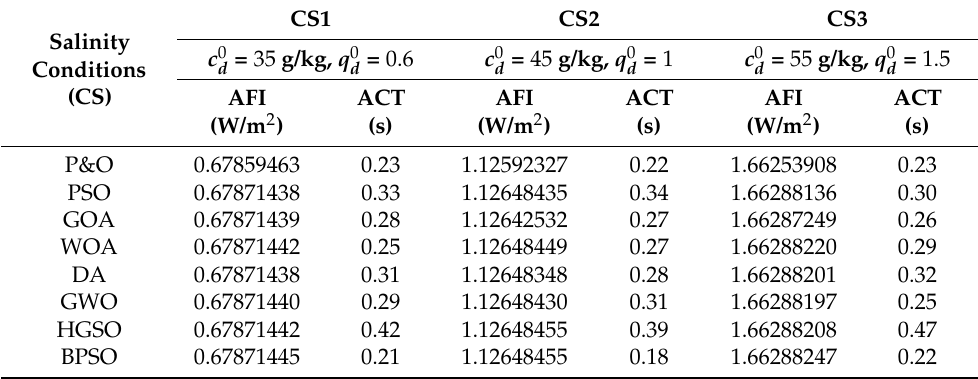
Table 6. Comparative analysis of the extracted average power density from the different proposed MPPT controllers under rapidly changing salinity profiles, namely the draw concentrations and flow rates.